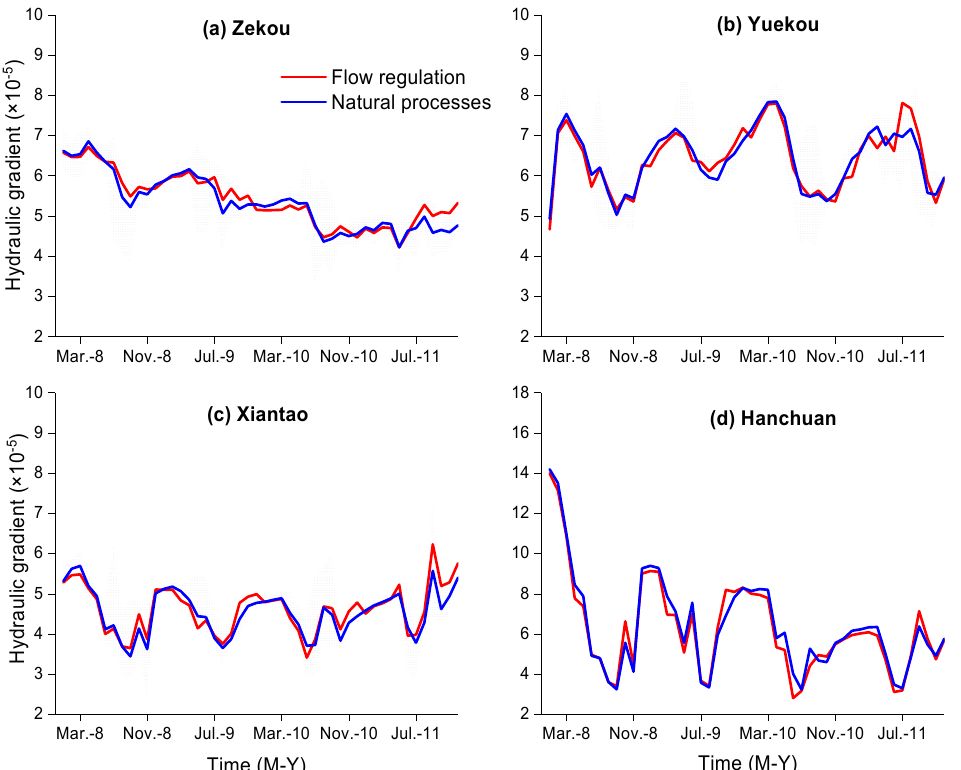
Figure 8. The monthly average hydraulic gradient at the different gauging stations with and without the TGR. The shaded area denotes the monthly minimum and maximum hydraulic gradient.